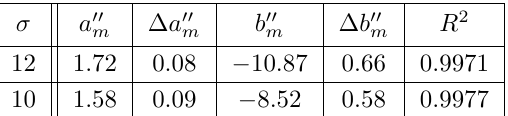
Table 13 . Parameters of the fit (4.6) with respect to α m for two values of the resonance parameter σ = 12 , 10 and bath temperature exponent α a = 3 . ∆ a 00 respectively. R 2 is the R-squared goodness of the fit. a 00 , b 00 m m